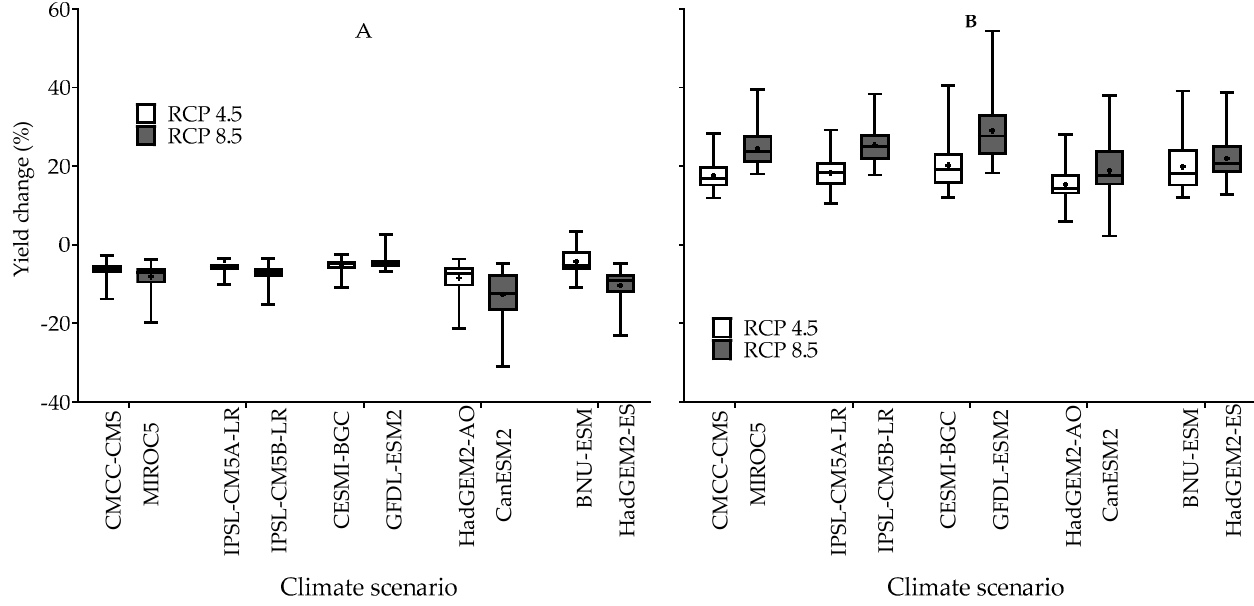
Figure 10. Impact of climate change on simulated soybean yield under ( A ) ambient and ( B ) elevated carbon dioxide concentrations, two RCPs (4.5 and 8.5) and 5 different climate scenarios. Each box in the graph shows the distribution of relative yield change across farms. The line within the box marks the median, the dots depict the means.